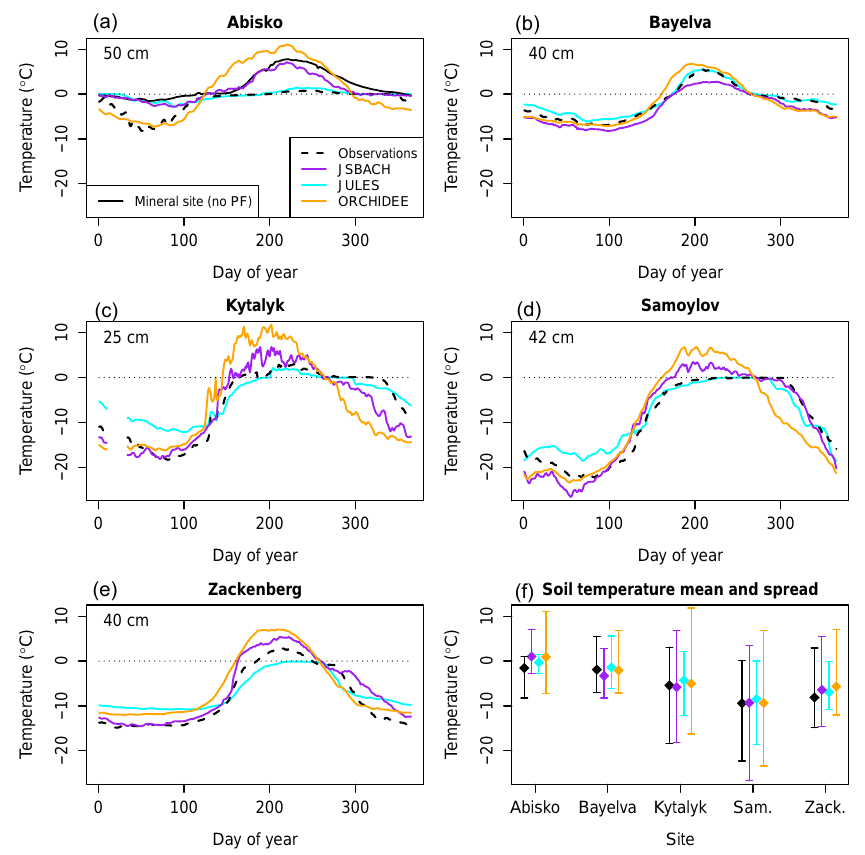
Figure 2. Mean annual cycle of soil temperature at each site, showing both observations and models. Depths of observations: Abisko: 50cm; Bayelva: 40cm; Kytalyk: 25cm; Samoylov: 42cm; Zackenberg: 40cm. JULES and ORCHIDEE take the nearest soil layer and JSBACH is interpolated to the correct depth, as soil layers are not resolved well enough to get close to the right depth. In panel (f) , Samoylov and Zackenberg are abbreviated to “Sam.” and “Zack.”. See Table S1 for the years used at each